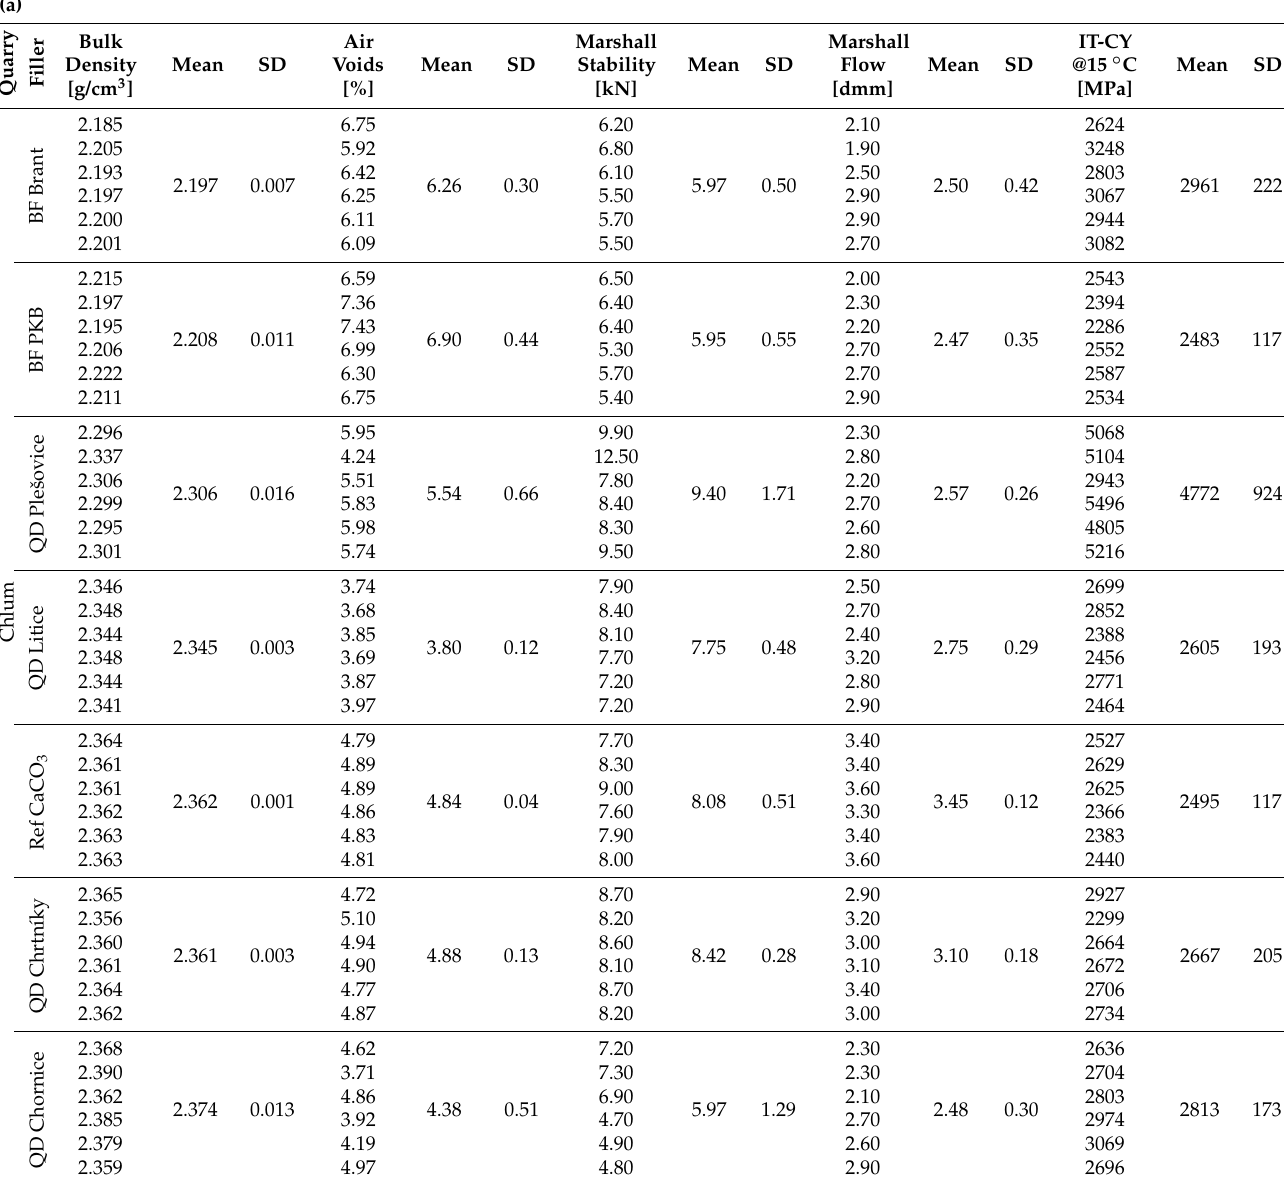
Table 2. (a) Mechanical and volumetric characterization of AMs prepared with different fillers; aggre- gate type phonolite (Chlum quarry). (b) Mechanical and volumetric characterization of AMs prepared with different fillers; aggregate type granite porphyry (Brant quarry). (c) Mechanical and volumetric characterization of AMs prepared with different fillers; aggregate type spilite (Zbeˇcno